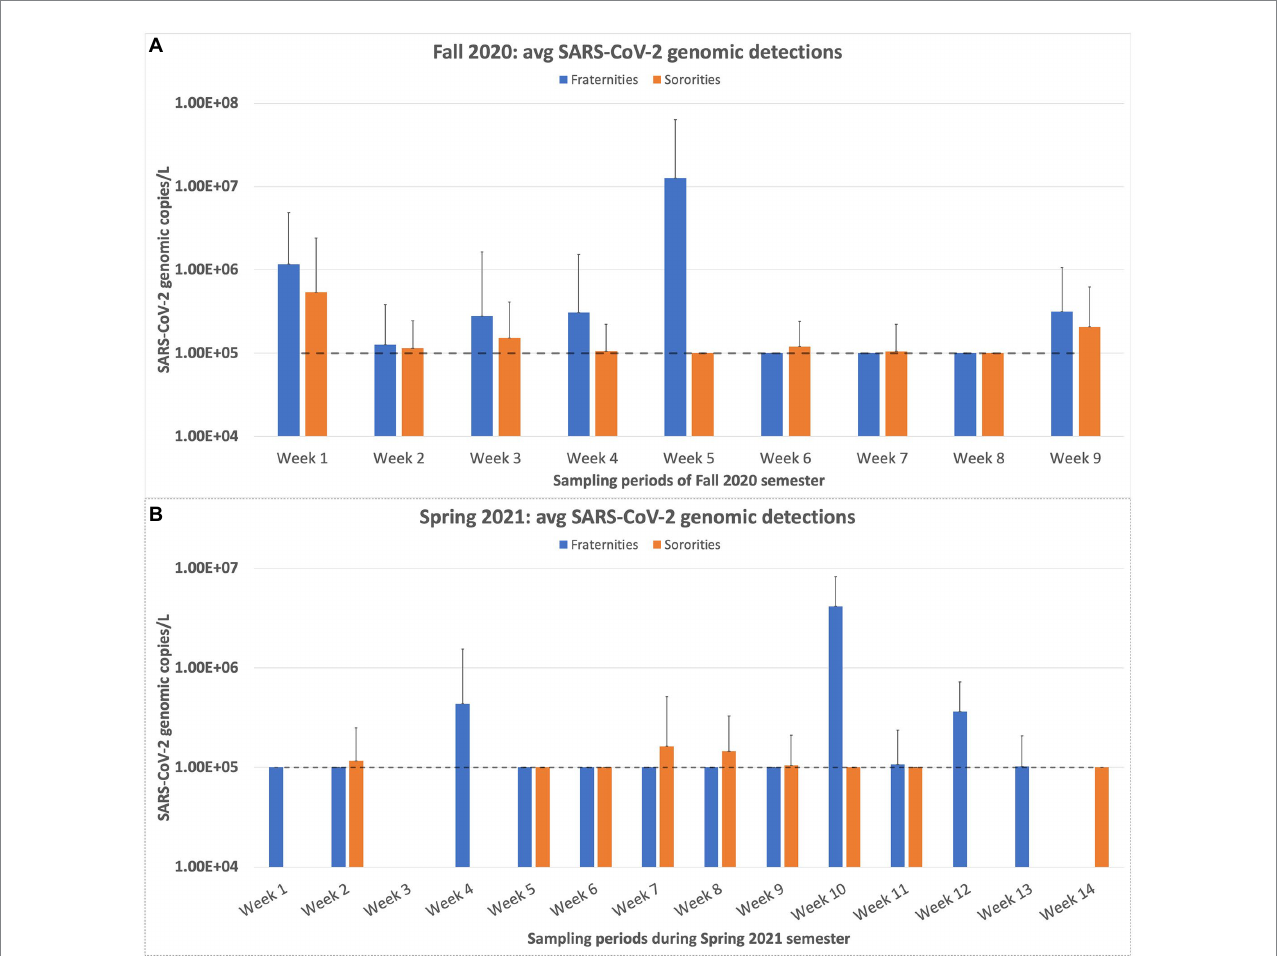
FIGURE 6 Weekly Sampling results for the residences of the Greek village on campus. (A) represents the weekly sampling results of the Fall 2020 semester. (B) displays the weekly sampling results for the Spring 2021 semester. The dashed line in both charts represents the limit of quantification for the N1 RT-qPCR assay. Any positive samples deemed “below quantifiable levels” are listed at 10 copies/ μ l. The error bars represent the maximum range of the positive sample concentrations above the